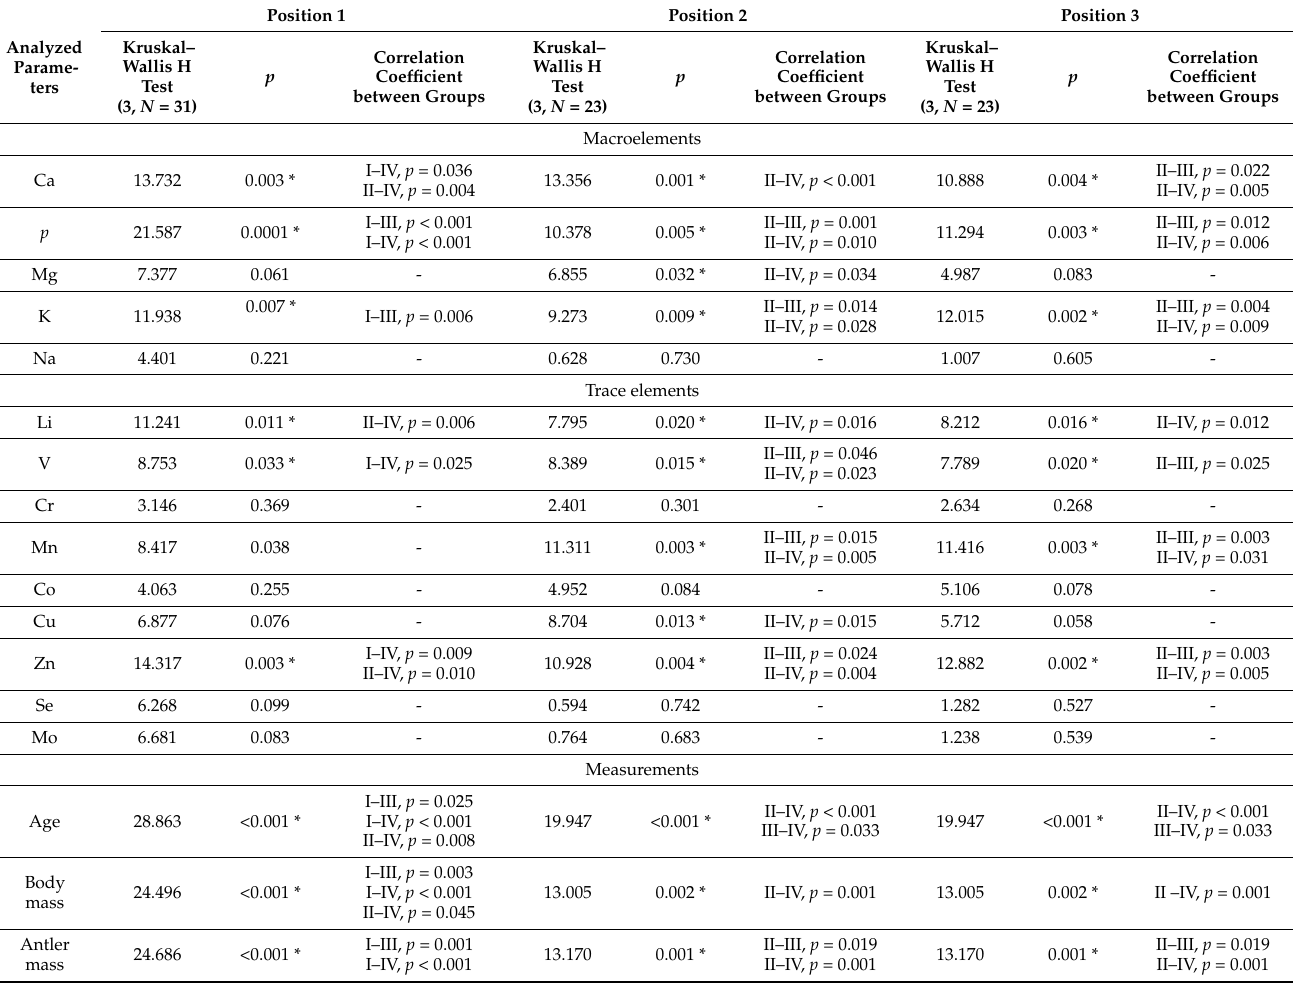
Table 4. Comparison of measurements of macroelements and trace elements from individual positions between